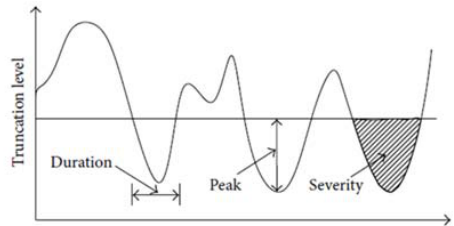
Figure 3. Drought characteristics extracted by the run